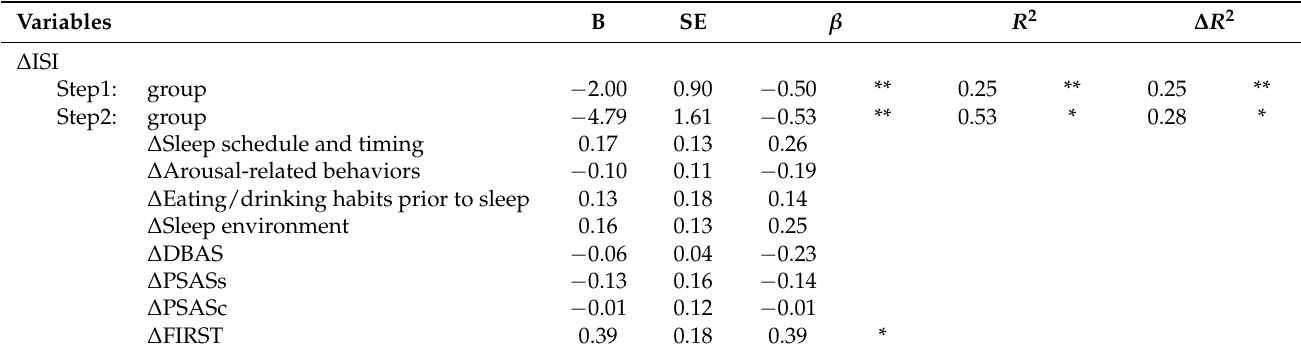
Table 2. Results of the multiple regression analysis.